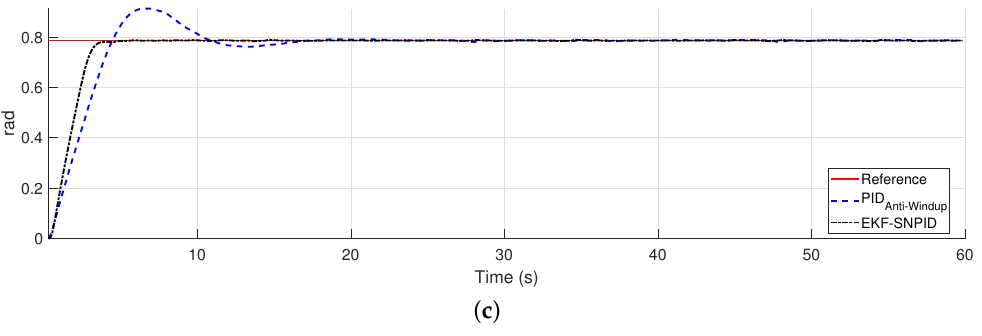
Figure 22. System response for the rose curve trajectory. ( a ) System response for x . ( b ) System response for y . ( c ) System response for θ .